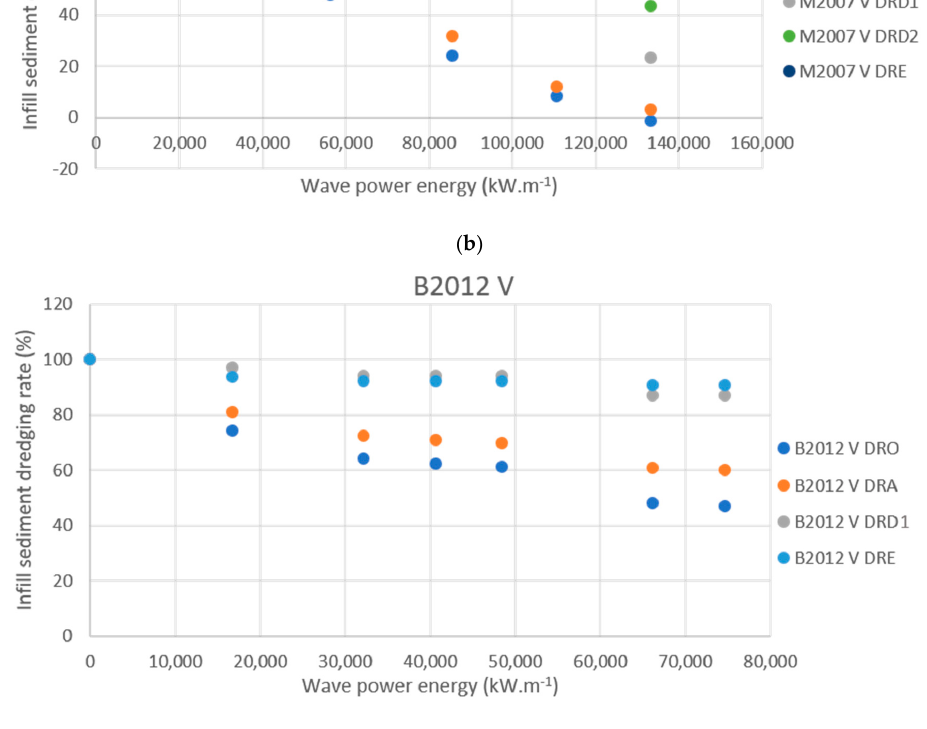
Figure 7. Remaining sediment volume in the sedimentation basin based on wave energy power accumulated during the simulation period for each dredging scenario under di ff erent wave climate scenarios: ( a ) high-energy wave (A2014), ( b ) medium-energy wave (M2007), ( c ) low-energy wave (B2012). The results are depicted with an interval of 15 days. The detailed analysis of the dredged area for the different scenarios studied revealed the effect of the area and the depth of the sedimentation basin in the percentage of the remaining volume at the dredging scenarios (Figure 7). It was verified for all wave conditions that small volume dredging operations such as DRO (V do = 155 × 10 3 m 3 ) filled more quickly than high volume dredging operations such as DRE (V do = 2925 × 10 3 m 3 ). Under the high-energy wave scenario (Figure 7a), DRO, DRA, and DRD completely filled after 30 days (wave energy power accumulated of 113,115 kW.m -1 ) whereas DRE filled after 60 days (wave energy power accumulated of 228,302 kW.m -1 ) (Figure 7a). Under the medium-energy wave scenario, DRO and DRA completely filled after 90 days (wave energy power accumulated of 133,360 kW.m -1 ) whereas DRD1, DRD2, and DRE had free 23%, 43%, and 77% of their capacity (Figure 7b). Under the low-energy wave scenario, no dredging scenario completely filled after 90 days (wave energy power accumulated of 74,629 kW.m -1 ) (Figure 7c). 4.2.2. Dredging Scenarios’ Lifetime under Wave Climate Conditions (1958–2017) Knowledge of the lifetime of a dredging operation under current wave climate conditions is an important issue for stakeholders. Based on the wave climate data series (SIMAR 1042062 point (1958– 2017)), the time, T*, needed to achieve the accumulated wave power energy that corresponds to 90% of infill, according to Figure 7, was computed for each year. The mean values and the percentiles of T* were computed and are presented in Figure 8 for each dredging scenario. Two periods to perform dredging operations were considered: one at the beginning of winter wave climate (1 October) and other at the end (1 April). The lifetime of dredging operations is more variable for big dredging scenarios (i.e., DRD2 and DRE). This lifetime depends on the period of year they are carried out and its configuration (i.e., dredged sediment volume). The mean lifetime decreased when the selected dredging period was at the beginning of the winter (Figure 8b) because high-energy wave conditions contribute more to sediment accretion inside sedimentation basin. This reduction was higher for small dredging scenarios (i.e., DRO and DRA) where the life diminished by half (100 days) whereas